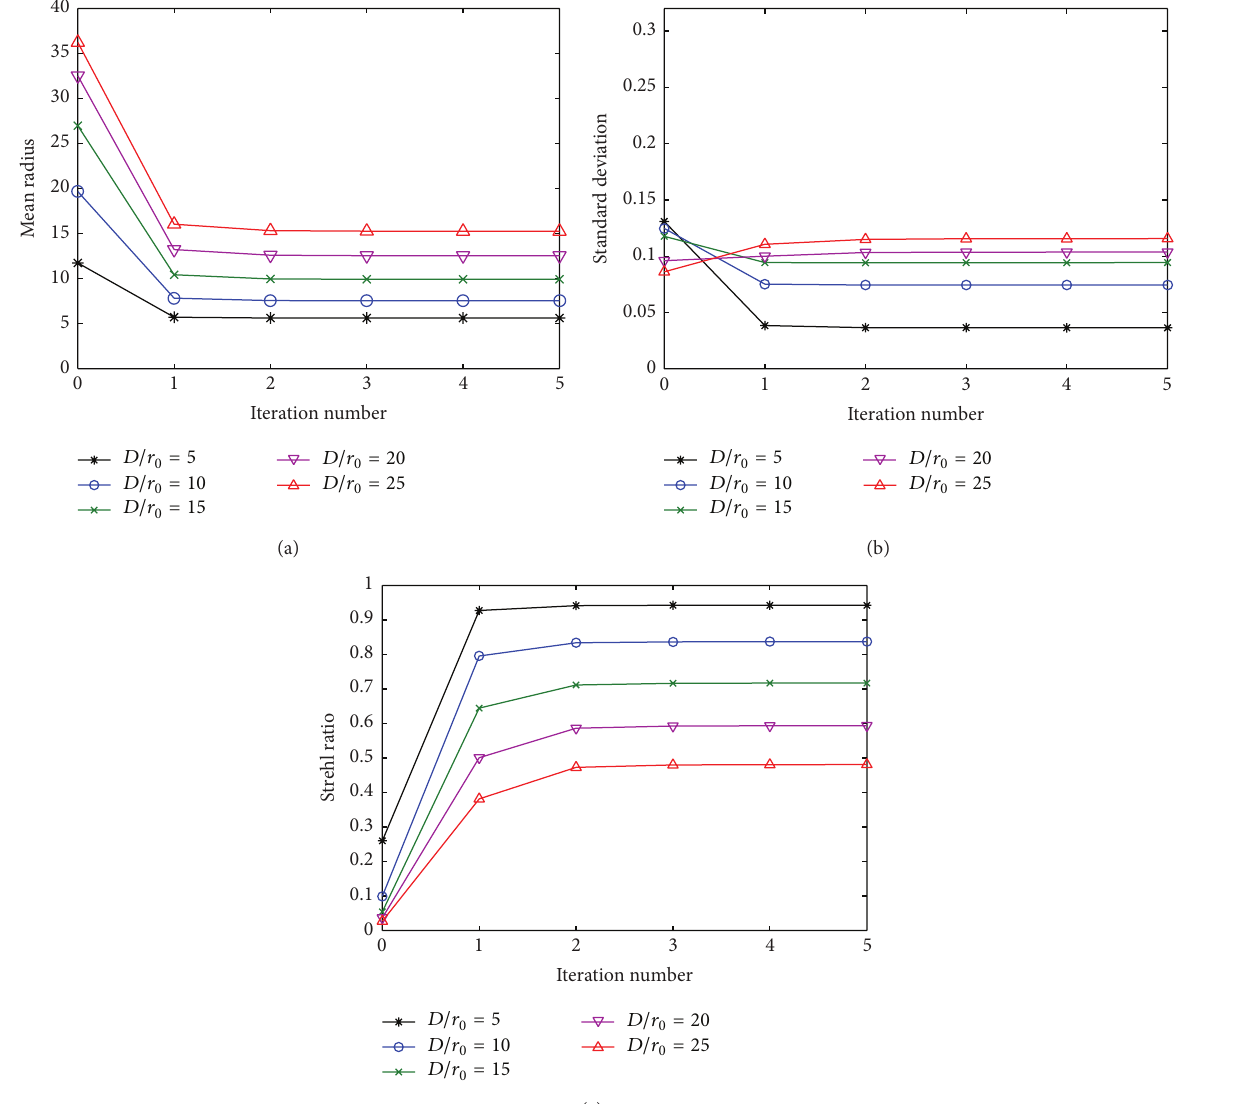
Figure 4: Averaged adaptation process over 500 different phase screens under different turbulence strengths. (a) MR curves, (b) standard deviation curves of MR, and (c) SR